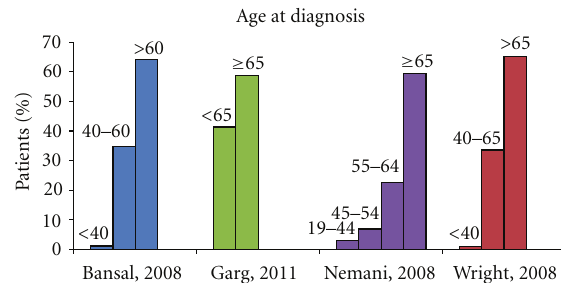
Figure 2: This column graph demonstrates the age distribution among the four of the six index large case-based series of Bansal et al. [8], Garg et al. [10], Nemani et al. [12], and Wright et al. [13]. Garg et al. [11] and Clayton Smith etal. [9] are not included, as this data was not provided. The numbers on top of each bar indicates the age range it comprises, as each study categorized patients within di ff erent age groupings. This graph demonstrates the predominance uterine carcinosarcomas have for an older, postmenopausal